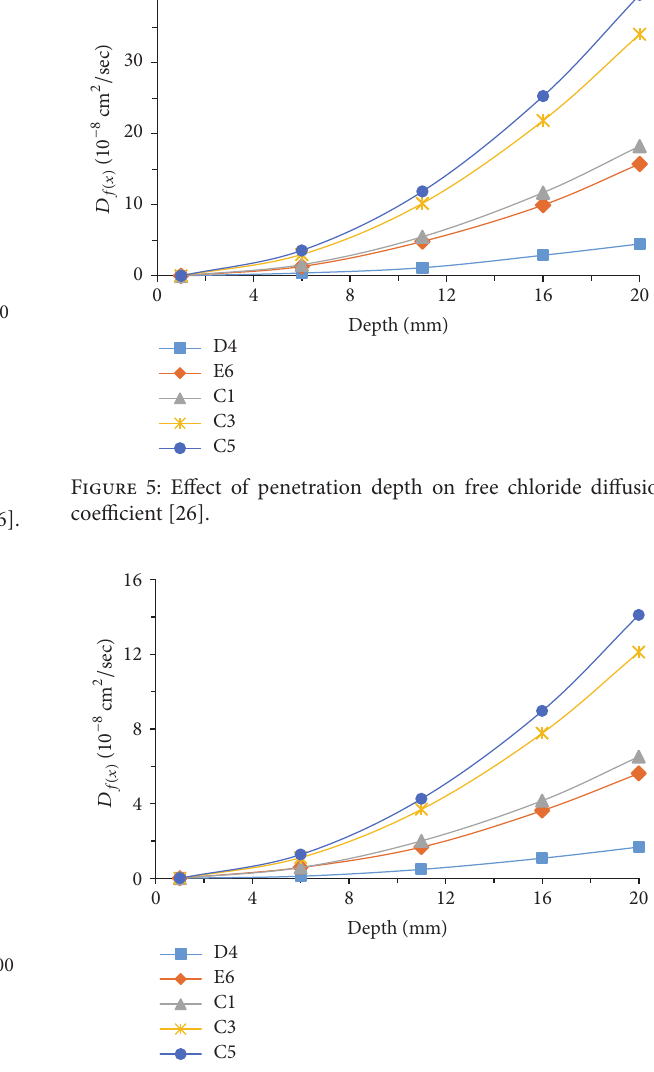
Figure 6: Effect of penetration depth on total chloride diffusion coefficient